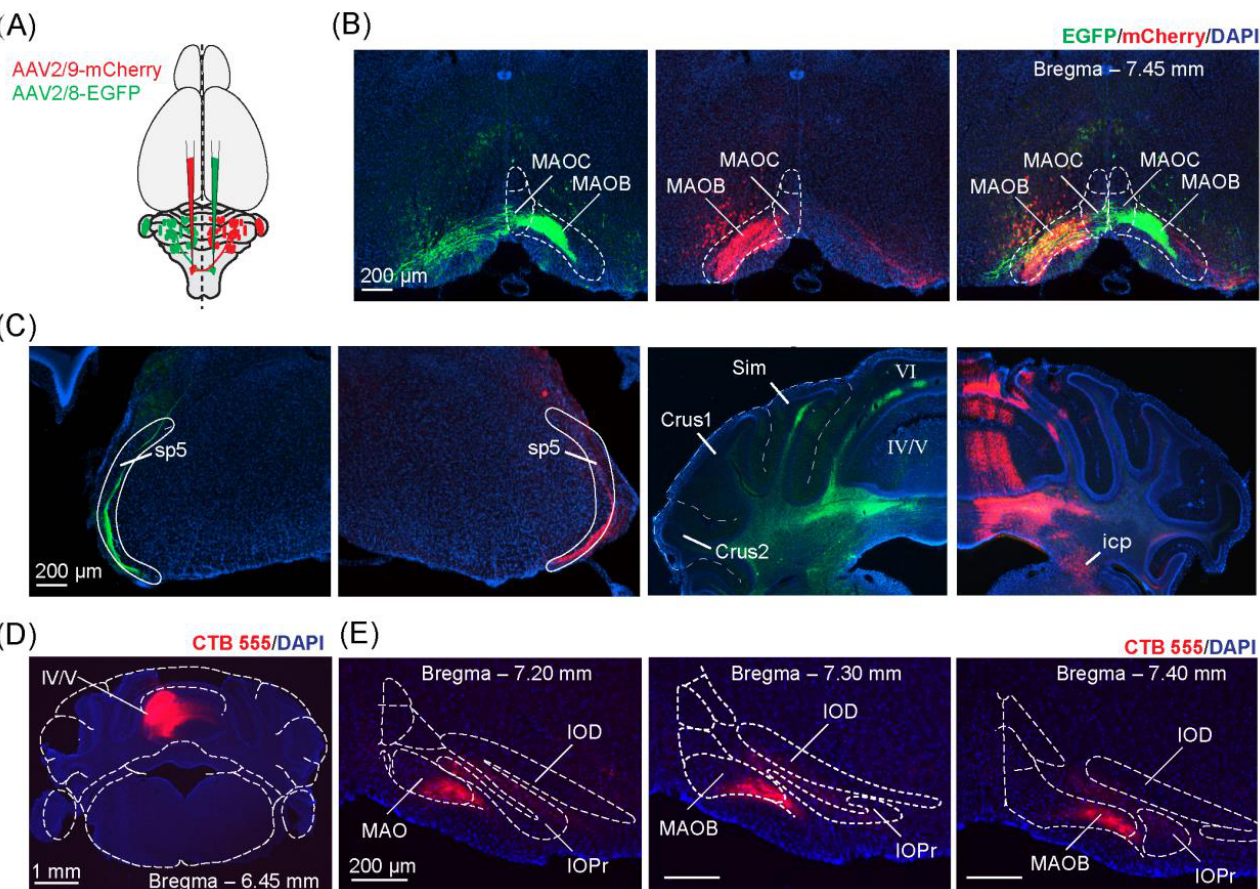
Figure 2. Verification of olivocerebellar projection to specific cerebellar lobules using anterograde tracers. ( A ) Schematic diagram of the bilateral injection of the adeno-associated viruses (AAV). AAV2/8-hSyn-EGFP-WPRE-pA and AAV2/9-hSyn-mCherry-WPRE-pA were used. ( B ) Coronal sec- tion showing virus expression in the caudal IO at the injection site. Scale bar = 200 µ m. ( C ) Coronal sec- tion showing anterograde labeling following injections into the IO depicted in ( B ). Scale bar = 200 µ m. sp5, spinal trigeminal tract; icp, inferior cerebellar peduncle; sim, simple lobule; crus1, crus 1 of the ansiform lobule; crus2, crus 2 of the ansiform lobule; VI, lobule VI of the cerebellar vermis; IV/V, lobules IV and V of the cerebellar vermis. ( D ) Coronal section showing the injection site of the retrograde tracer (CTB555), injected into lobule IV/V of the cerebellar vermis. Scale bar = 1 mm. ( E ) A series of coronal sections illustrating retrograde labeling following the injection in lobule IV/V of the cerebellar vermis depicted in ( D ). IOPr, principal nucleus of the inferior olive; IOD, dorsal nucleus of the inferior olive; MAO, medial accessory olive. Scale bar = 200